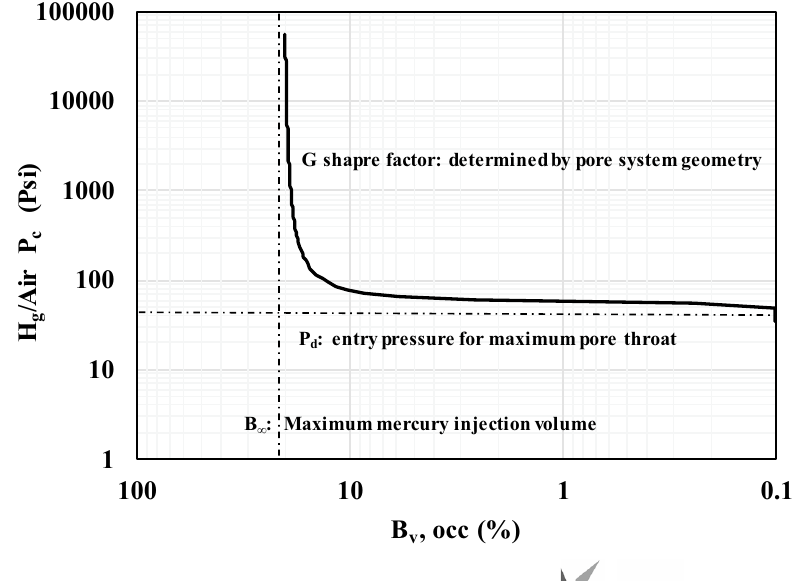
Fig. 1 Thomeer hyperbola with three fitting parameters illustrat- ing the pore system